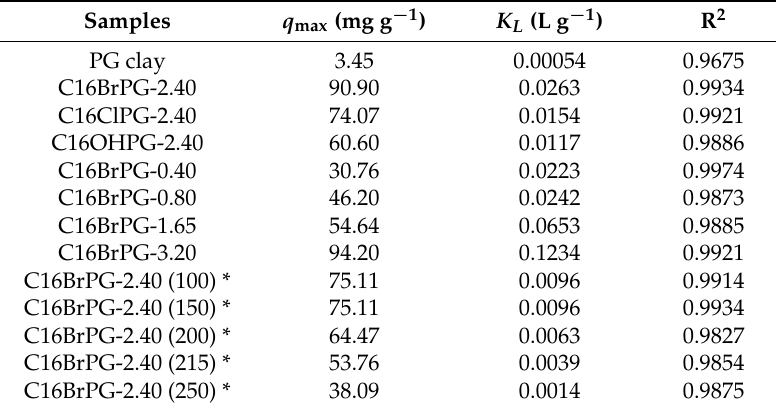
Table 9. Langmuir parameters of the eosin removal by different OCs.